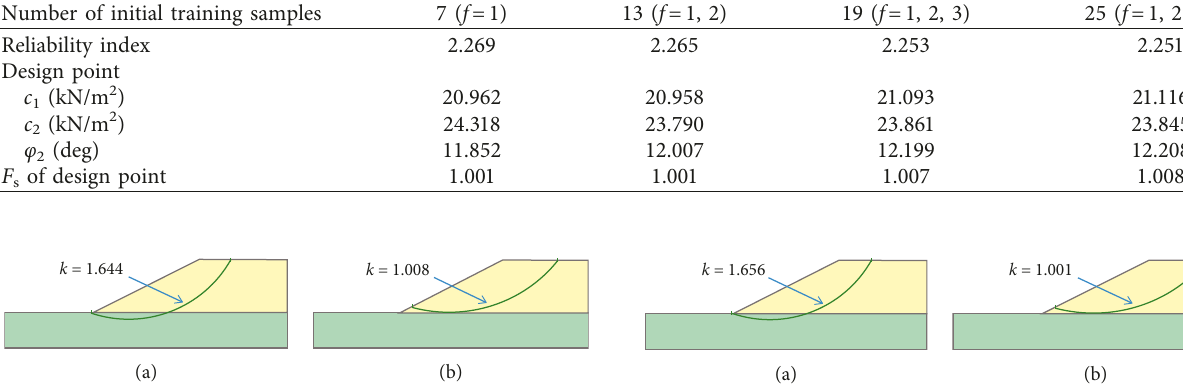
Figure 5: Example 2: results of the stability analysis by the Bishop method. Slip surface at (a) the mean point ( F s design point ( F s 1.008). (cid:28)